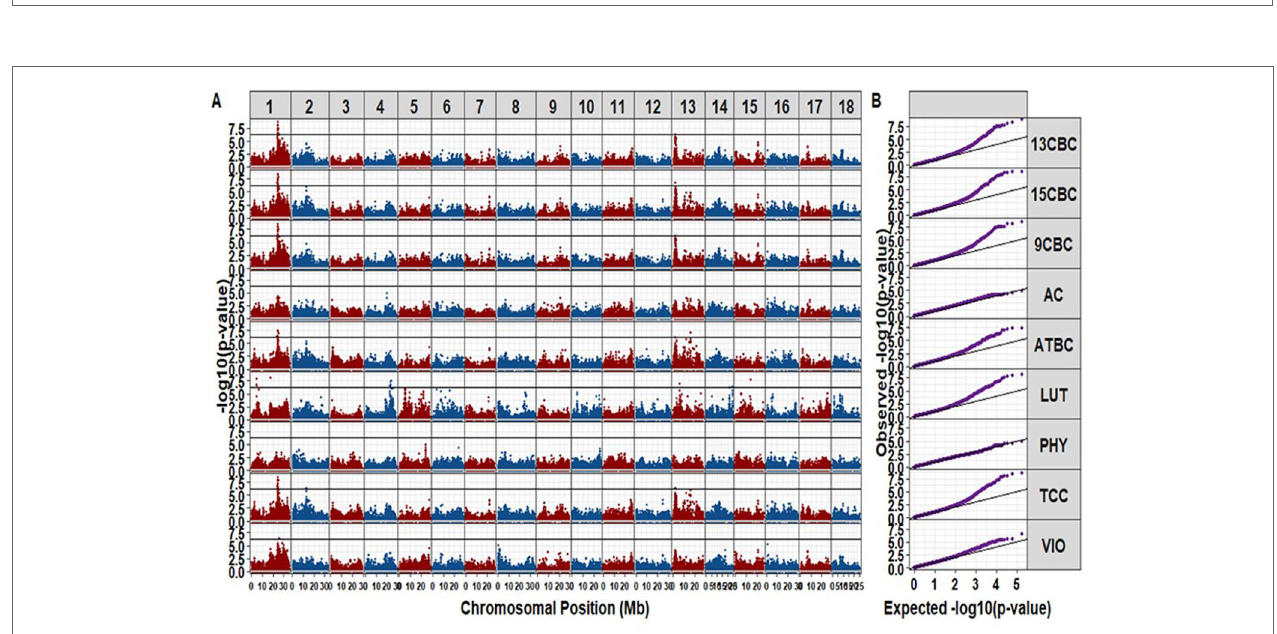
FIGURe 2 | The Manhattan (A) and QQ (B) plots of genome-wide association studies on cassava root total carotenoid content (TCC), all-trans β-carotene (ATBC), violaxanthin (VIO), lutein (LUT), 15-cis beta-carotene (15CBC), 13-cis beta-carotene (13CBC), alpha-carotene (AC), 9-cis beta-carotene (9CBC), and phytoene (PHY)